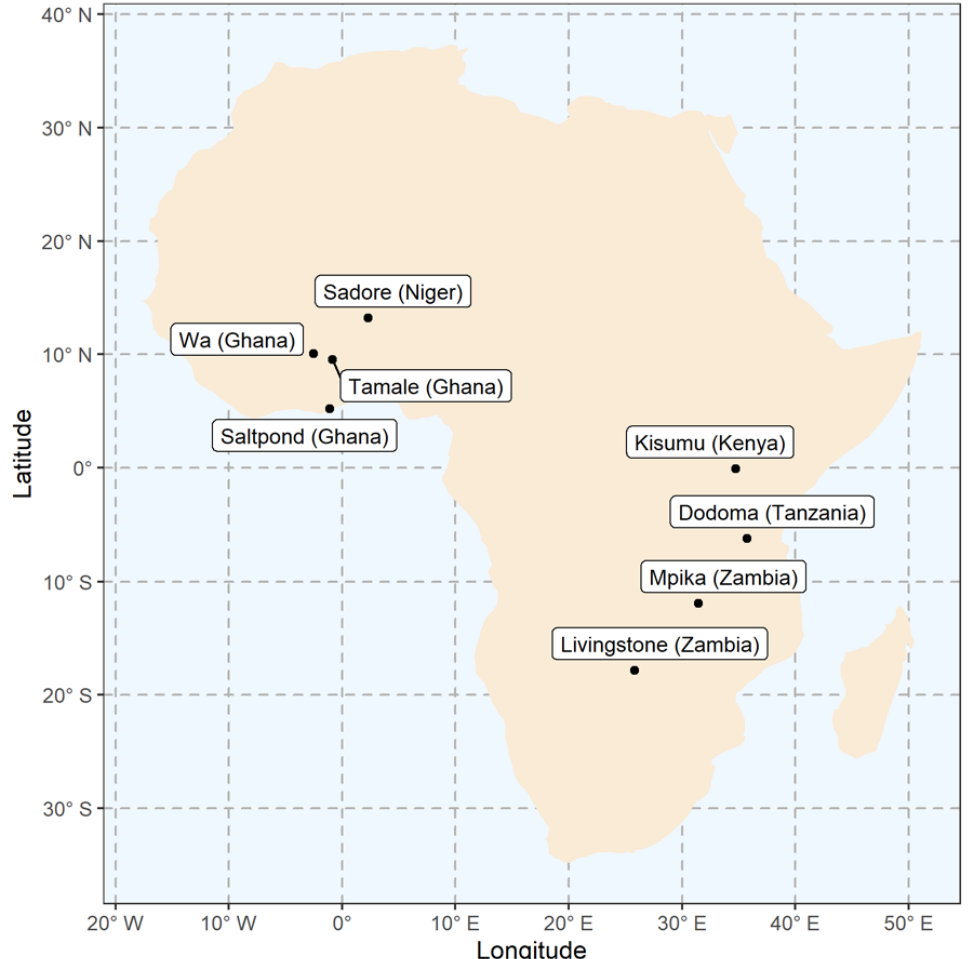
Figure 1. The location of the eight station sites.